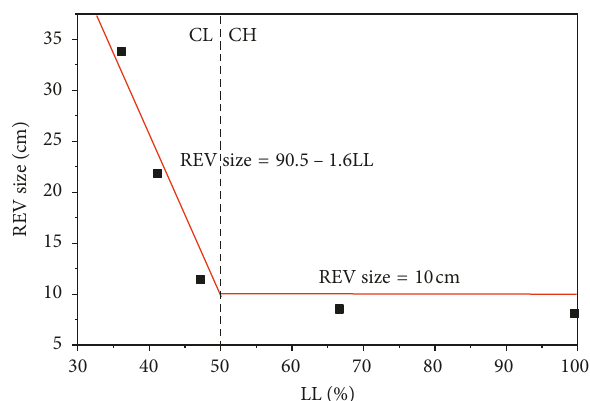
Figure 7: Relationship between REV and soil LL.